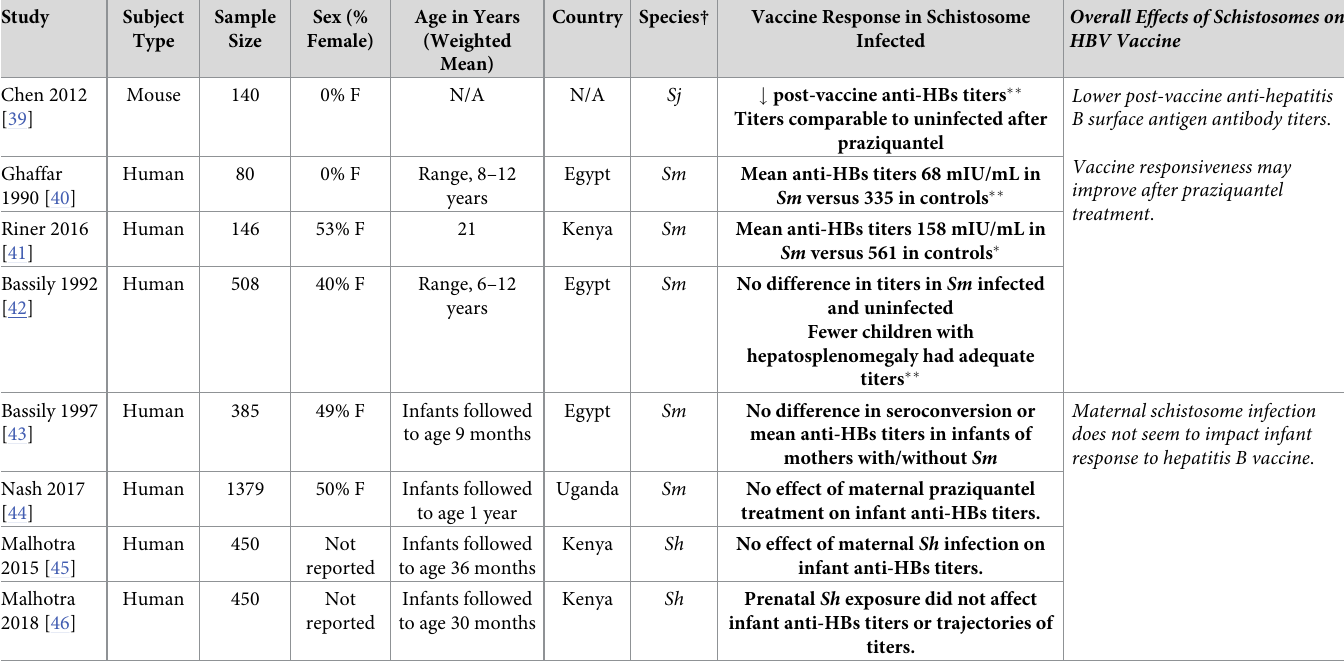
Table 2. Effects of Schistosome Infection on Response to Hepatitis B